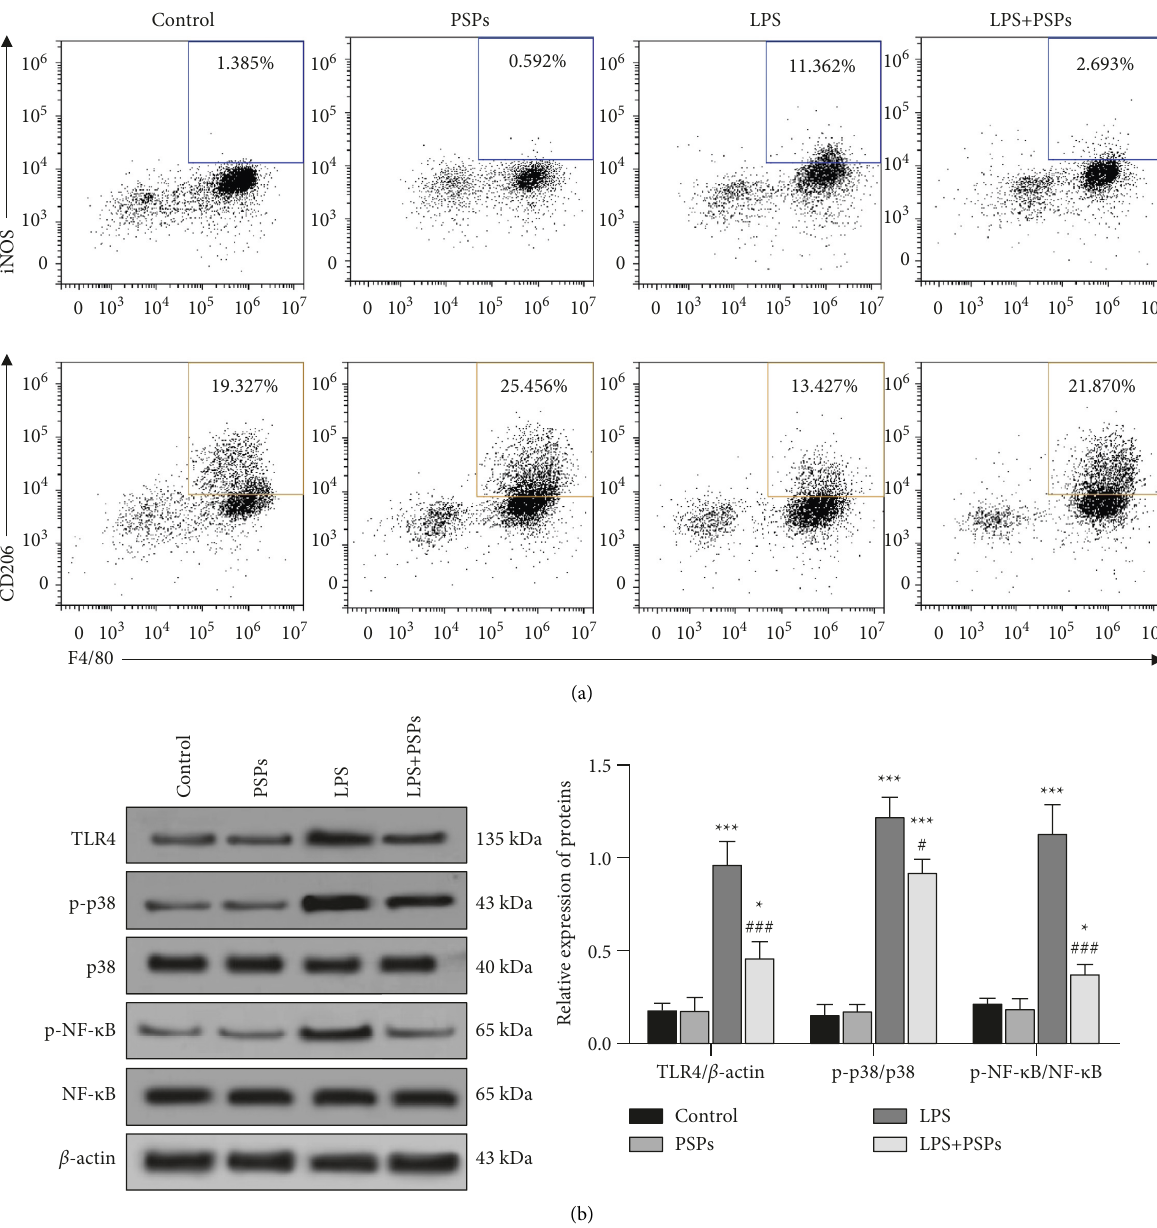
Figure 11: Effects of PSPs on M1 and M2 phenotypic polarization and TLR4-MAPK/NF- κ B signaling pathway of mouse macrophages. (a) The effect of PSPs on M1 and M2 phenotypic polarization of mouse macrophages was measured by flow cytometry. (b) The expression of TLR4-MAPK/NF- κ B signal proteins in lung tissue. Compared with the control group, ## P 0 .